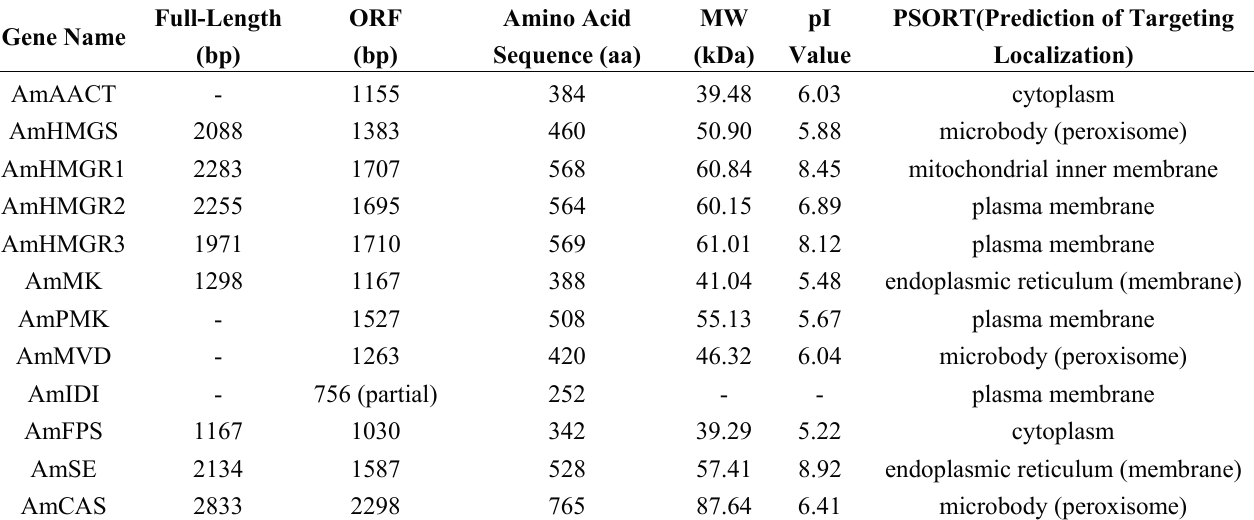
Table 1. Sequence analysis of genes obtained from A. membranaceus